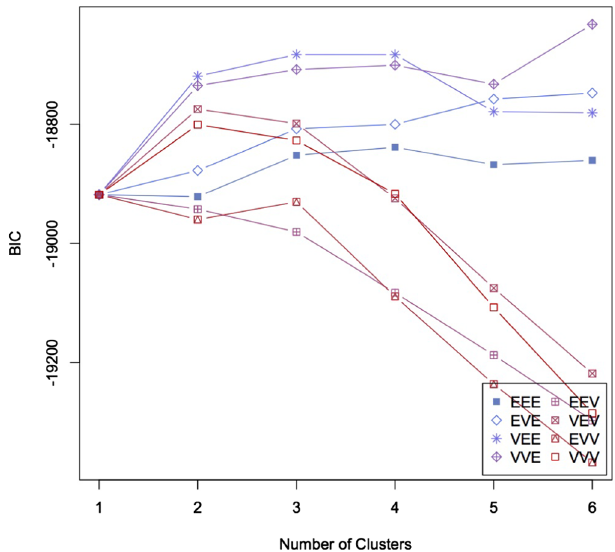
FIG. 1. Bayesian information criterion (BIC) values for various model-based clustering solutions.